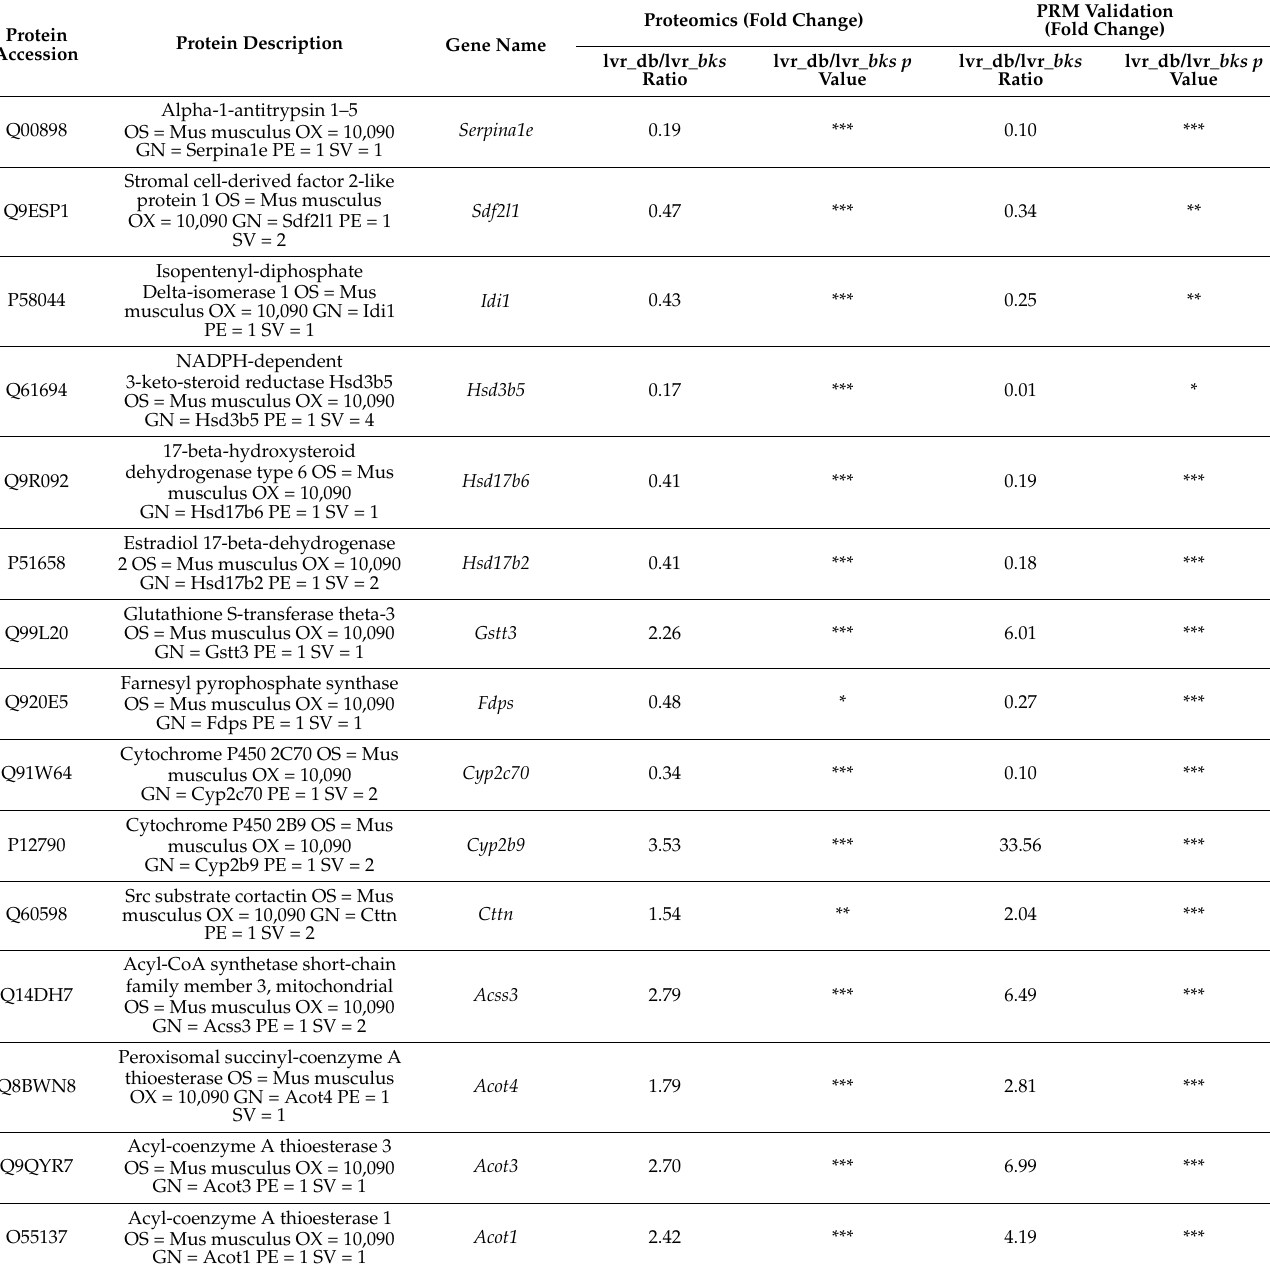
Table 4. DEPs generated by mice liver global proteomics validated by